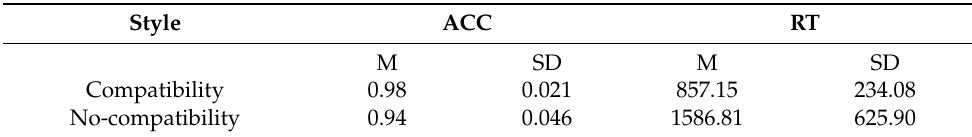
Table 4. The mean ACC and reaction time in different